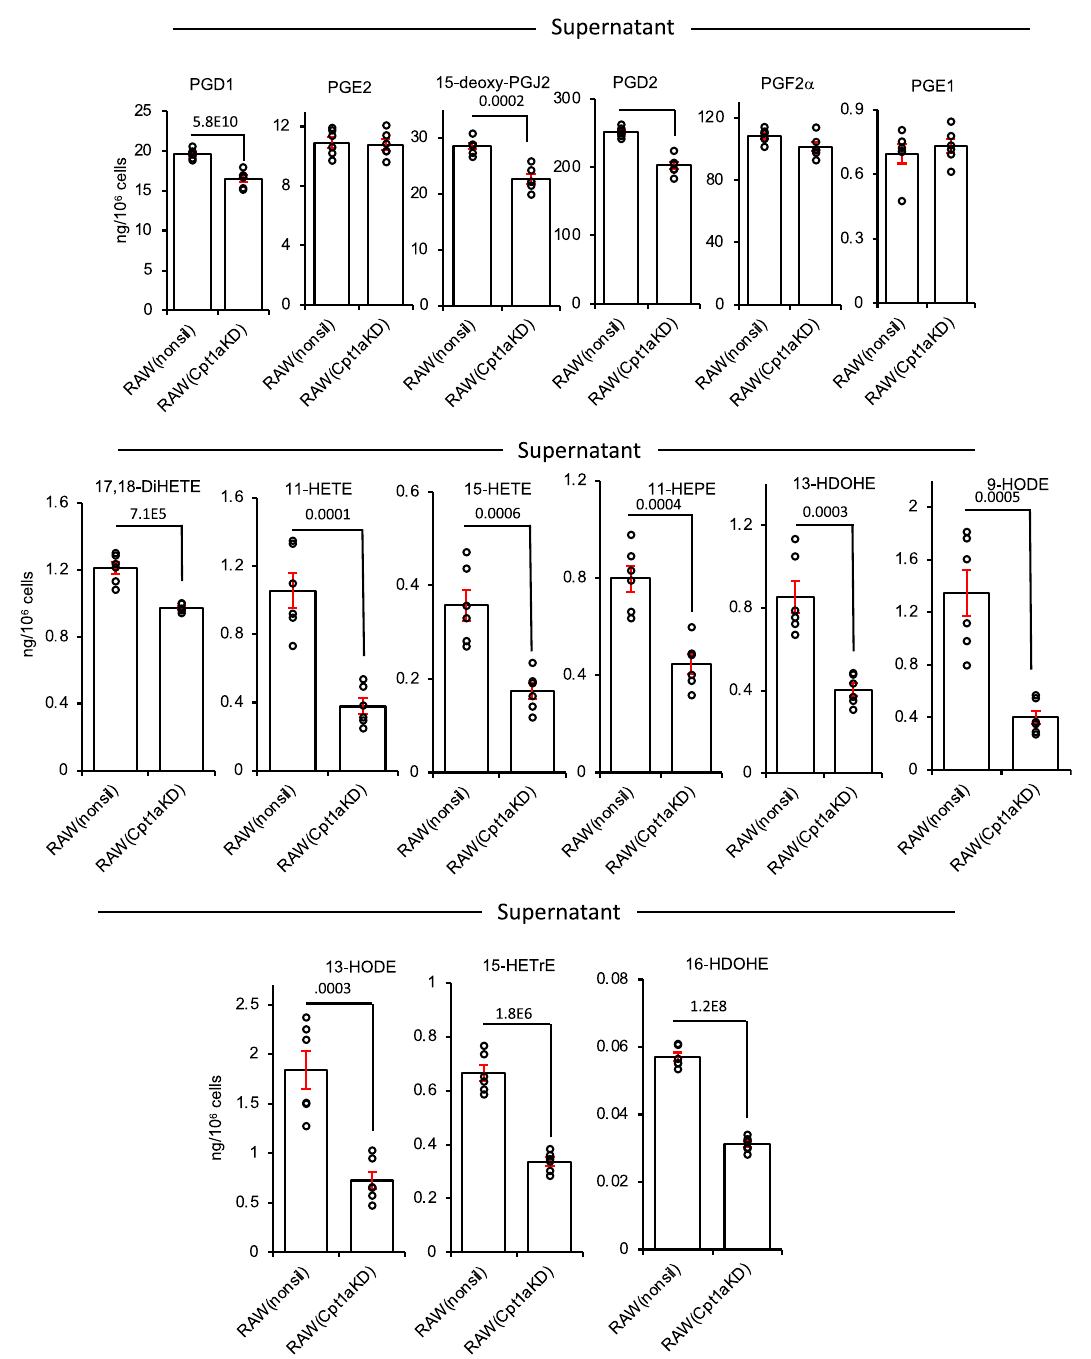
Fig. 4 CPT1 genetic knockdown reduces the secretion of oxylipins. RAW cells expressing either the non-silencing (RAW nonsil ) or Cpt1a knockdown siRNA (RAW Cpt1a KD ) were treated with LPS (100 ng/ml) for 24 h and secretion of PGs, 17,18-diHETE, or monohydroxy oxylipins were measured using LC/MS/ MS as in Methods ( n = 6, mean ± SEM, separate wells of cells). Student ’ s t -test, two-tailed. Where no bar is shown no signi fi cant difference was